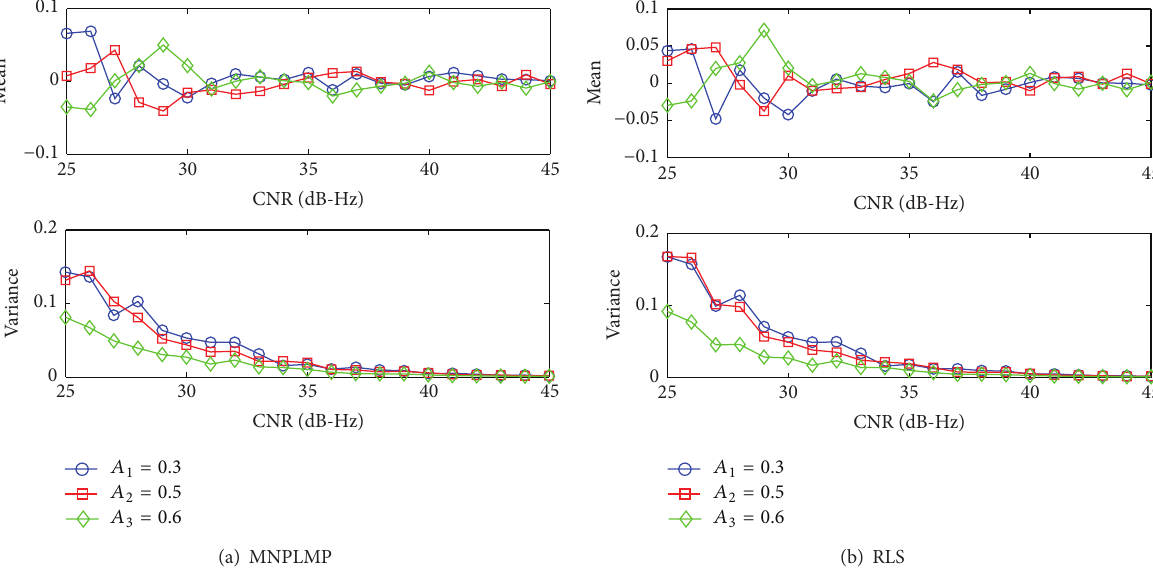
chips; and the window width of the average filter was set to 20 ms. The estimation of each delay was used to compensate the correlator output. Moreover, the error of the compensated output was transferred to the range error. The obtained error envelopes in the two noise conditions were shown in Figure 13. To obtain the error envelope curves, negative mul- tipath magnitude was also simulated though it had no special physical